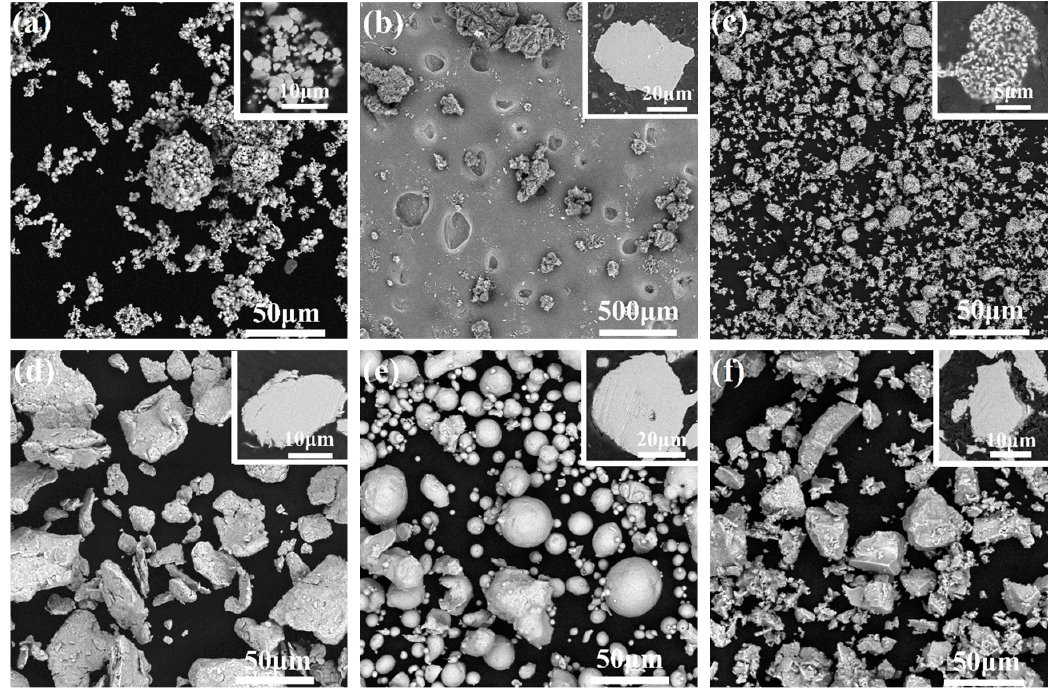
Figure 1. The surface and cross-sectional morphologies of the powders: ( a ) Mo, ( b ) B, ( c ) Co, ( d ) Cr, ( e ) Ni, and ( f ) Ti.